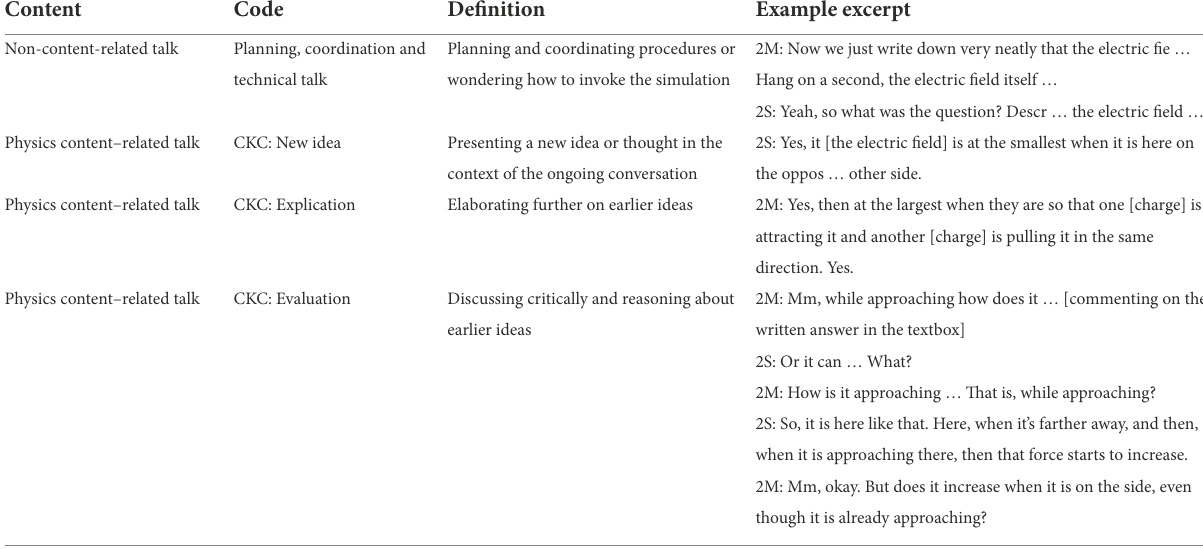
TABLE 2 Coding manual for non-content-related talk and physics content–related talk that includes a code for each level of collaborative knowledge